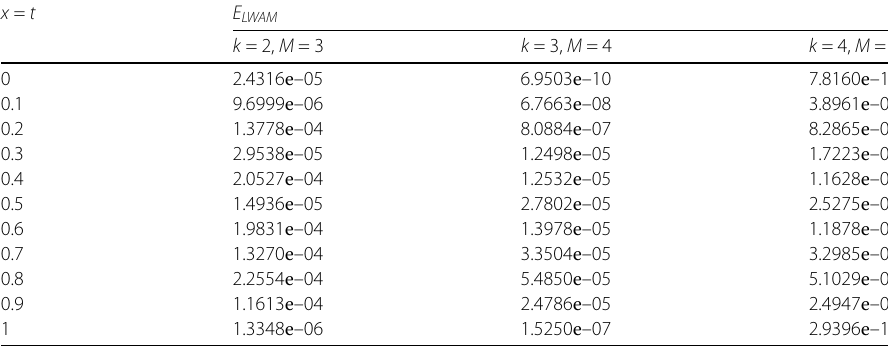
Table 4 Absolute errors for N = 6, different values of k , M , α = 1 in Example 2 x =